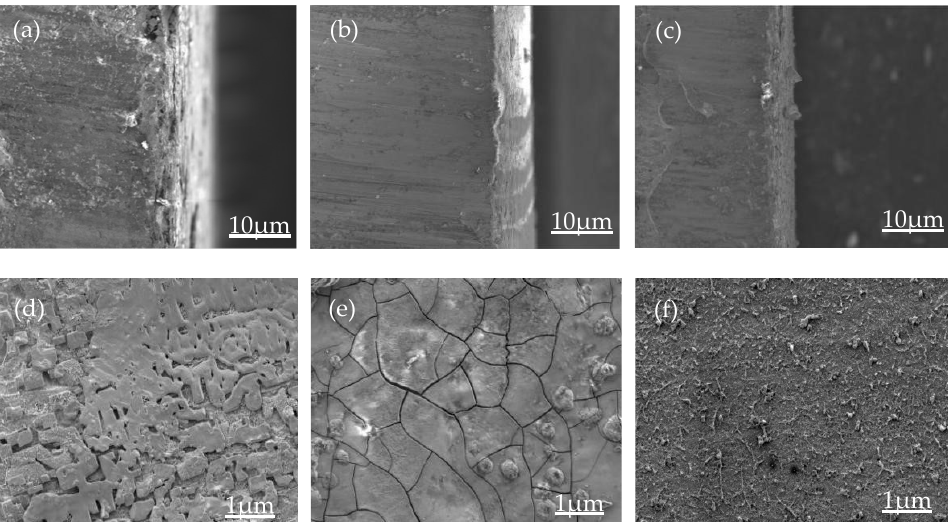
Figure 4. Surface micromorphology of Q235 steel sample in 3.5% NaCl solution. ( a ) SEM micrograph of cross section of unpassivated sample. ( b ) SEM micrograph of cross section of traditional phos- phating sample. ( c ) SEM micrograph of cross section of low phosphorus passivated sample. ( d ) SEM micrograph of the surface of unpassivated sample. ( e ) SEM micrograph of the surface of traditional phosphating sample. ( f ) SEM micrograph of the surface of low phosphorus passivated sample.